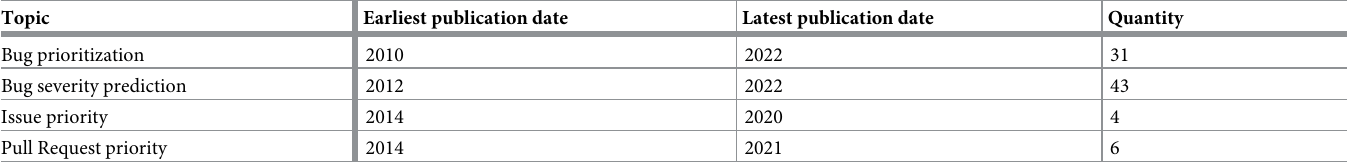
Table 4. Papers distribution by key topics. The table shows the number (column “Quantity”) of papers devoted to a particular key topic (column “Topic”). Note: 2 papers have content for both topic 1 and 2 distribution.